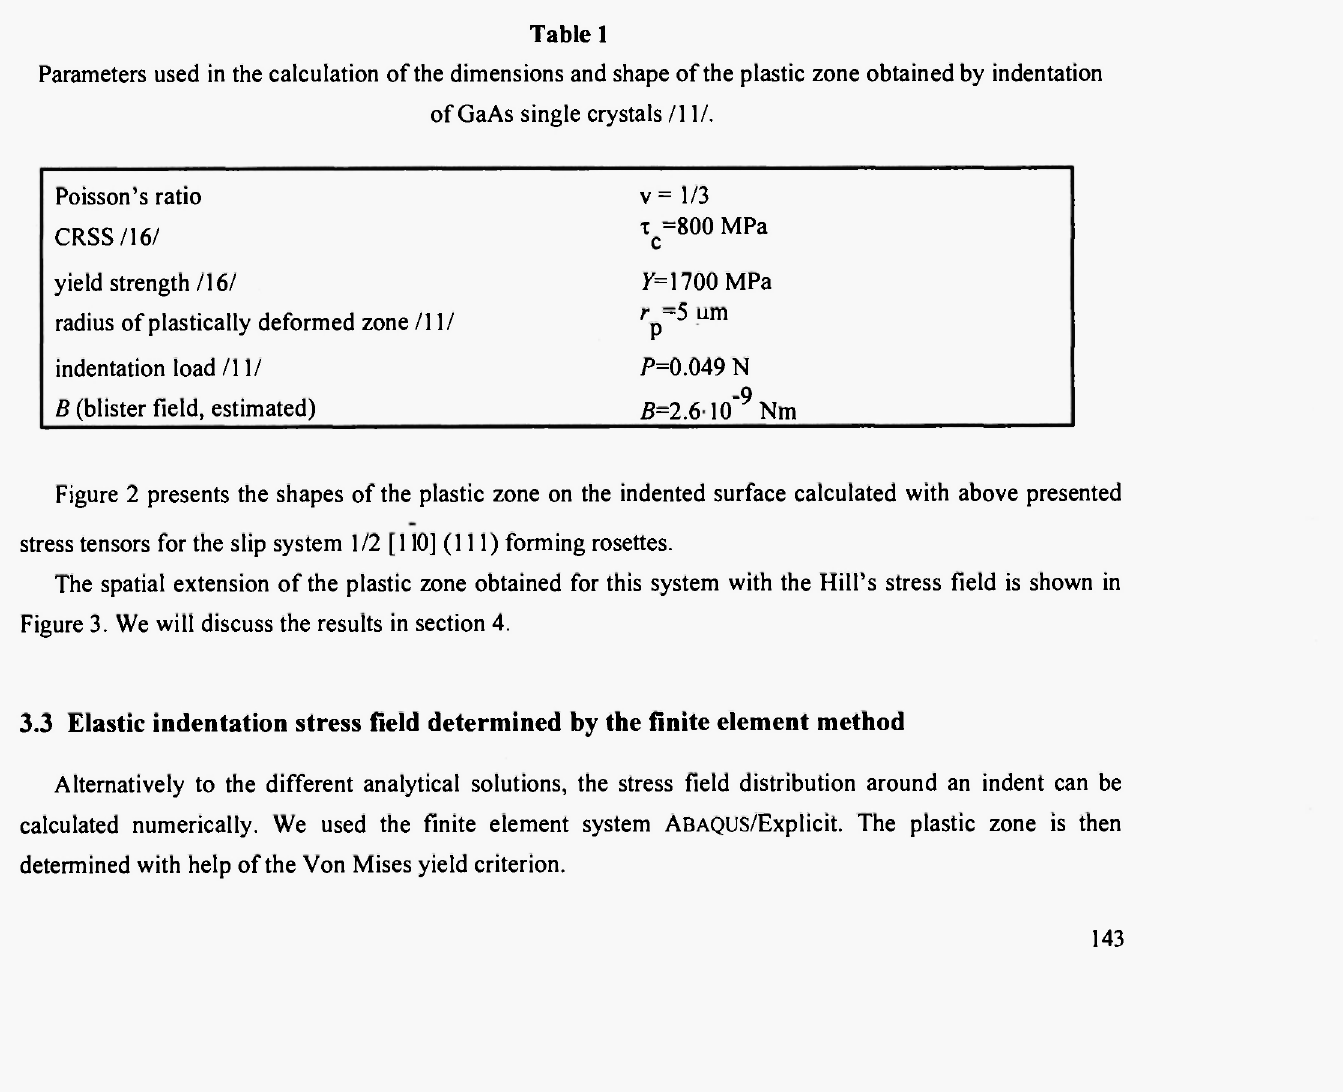
of GaAs single crystals